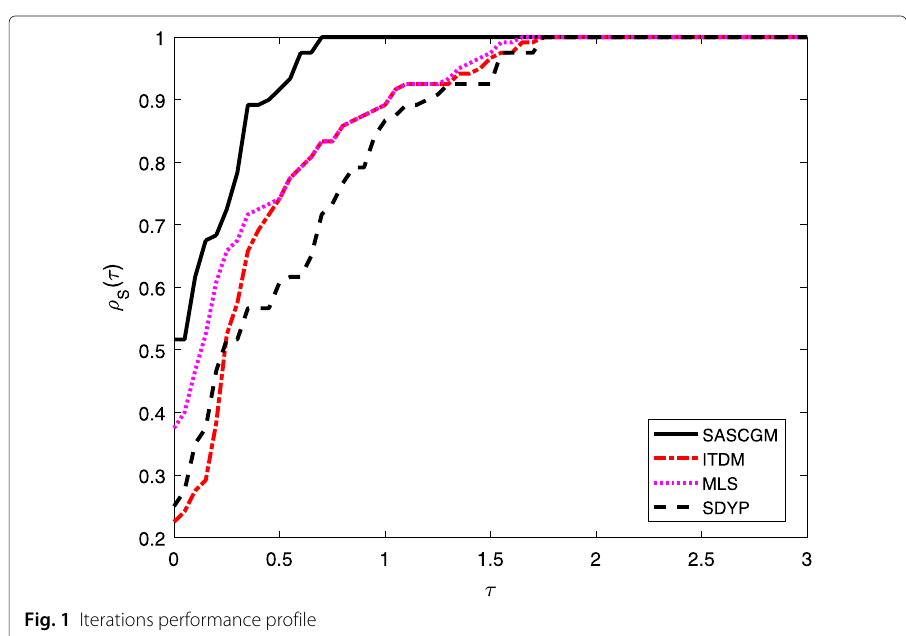
Fig. 1 Iterations performance profile